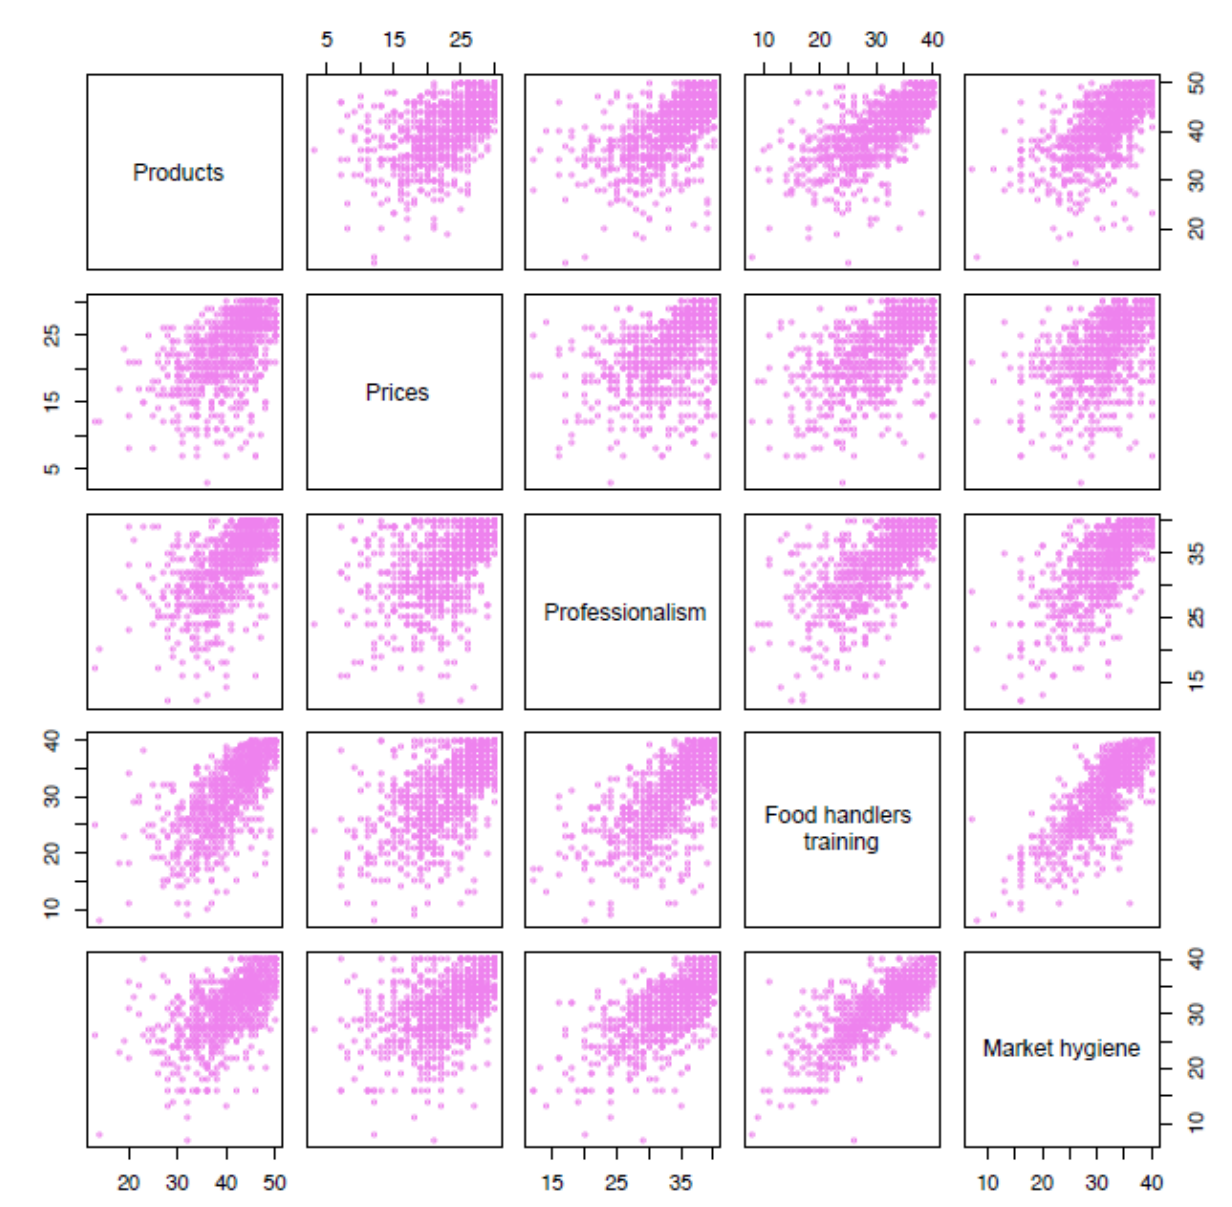
Figure 2. Dispersion diagram for all the pairs of the total five analyzed items.